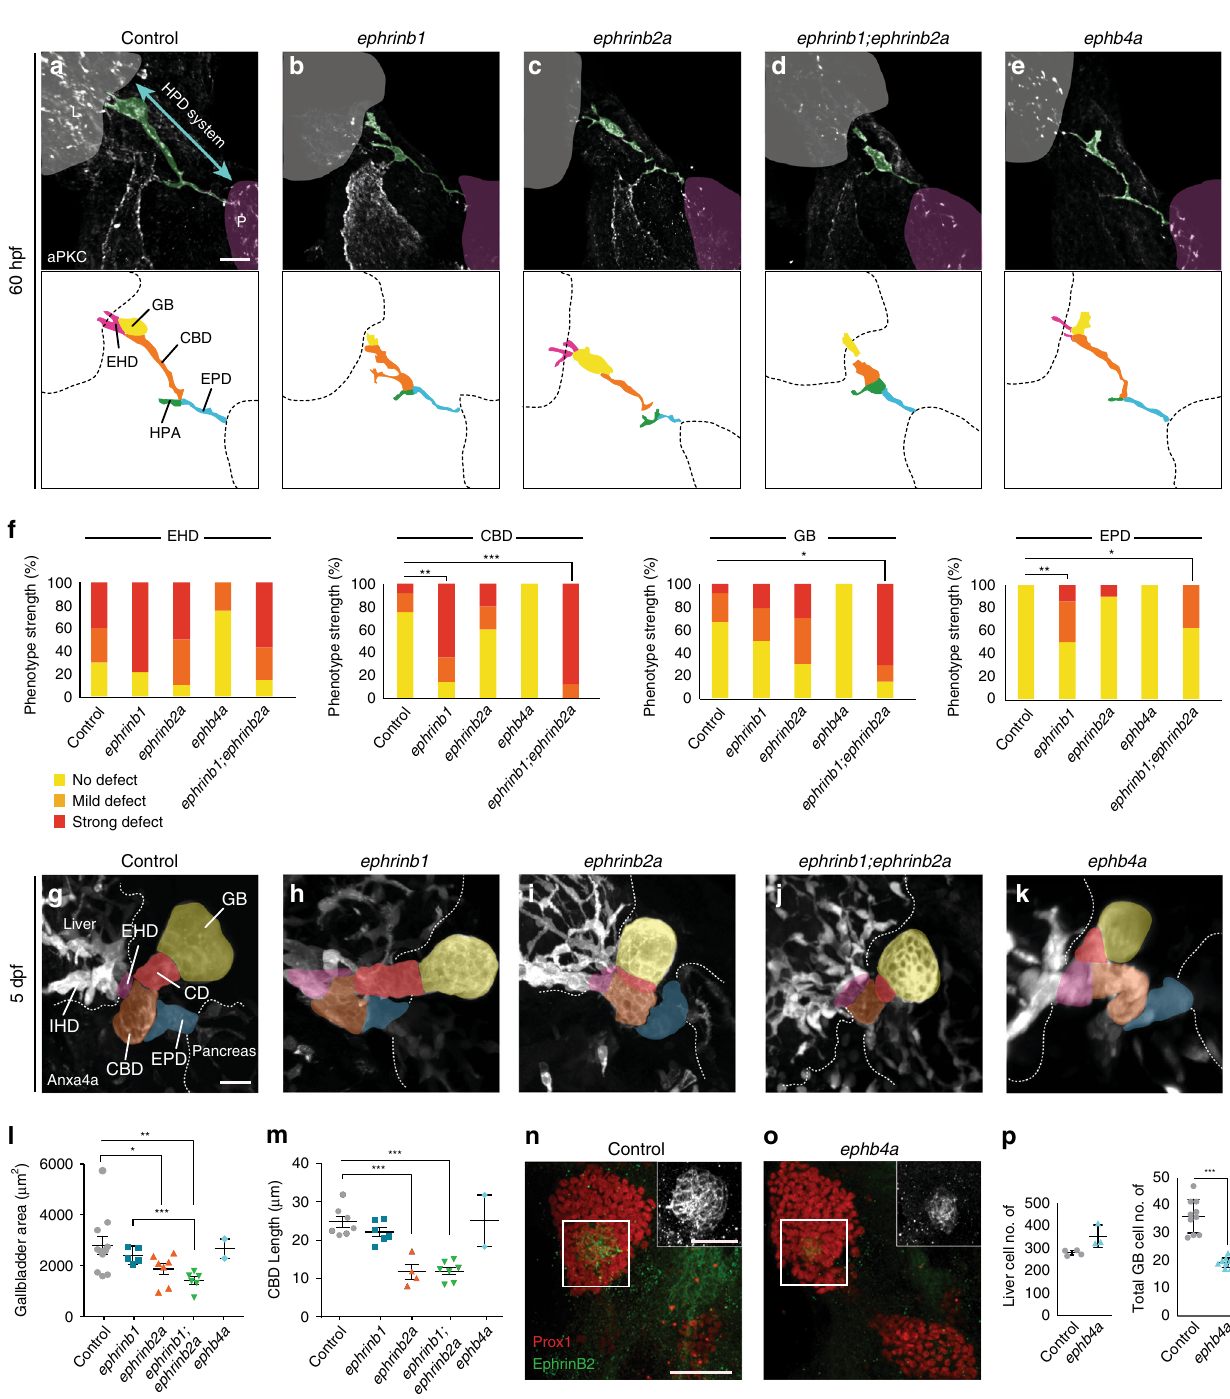
Fig. 7 EphrinB2a and EphB4 functions in gallbladder and CBD formation. Unlike sibling controls ( a ), ephrinb1 mutants ( b ) show disrupted ducts in the EHB region. ephrinb2a mutants ( c ) exhibit dysmorphic gallbladder and CBD (46.1% show the full phenotype, 53.9% show milder phenotype, n = 13, N = 2). d ephrinb1;ephrinb2a double mutants show additive EHB duct defect (100% n = 8, N = 1). e ephb4a mutants show no apparent HPD defect ( n = 4, N = 1). Schematics of immature HPD lumina show in a - e in domain-speci fi c color code. f Quanti fi cation of ephrinb1, ephrinb2a, ephb4a and ephrinb1; ephrinb2a double mutant HPD formation defects at 60 hpf, scored for individual HPD domains (control: n = 12; ephrinb1 : n = 14; ephrinb2a : n = 10; ephb4 a: n = 4, ephrinb1;ephrinb2a : n = 8); see Supplementary Fig. 3 for averaged scores from two assessors. g – k Early duct morphogenesis defects cause dysmorphic HPD appearance at 5 dpf in ephrinb1 , ephrinb2a and ephrinb1;ephrinb2a double mutants, while the HPD in ephb4a mutants appears control-like. (control: n = 10, N = 2; ephrinb1 : n = 6, N = 1; ephrinb2a : n = 7; ephrinb1;ephrinb2a : n = 6; ephb4a : n = 2) l Area quanti fi cation shows the gallbladder is signi fi cantly smaller in ephrinb1; ephrinb2a double mutants at 5 dpf. m Quanti fi cation of CBD length at 5 dpf shows signi fi cant differences in ephrinb2a and ephrinb1;ephrinb2a mutants. n – p In contrast to controls ( n ), fewer EphrinB2a-positive gallbladder precursors form in ephb4a mutants at 52 hpf ( o ). p Quanti fi cation of liver and gallbladder progenitor numbers (control and ephb4a n = 10). a - e : Scale bar = 15 μ m, g – k = 20 μ m. Statistical test: f = Fisher Exact, l , m , p = Student ’ s t - test. Error bars show SEM; * p < 0,05; ** p < 0,01; *** p < 0,001. Supplementary movies 1, 2, 5 – 9, 11 – 13 show HPD phenotypes at 60 hpf and 5 dpf.